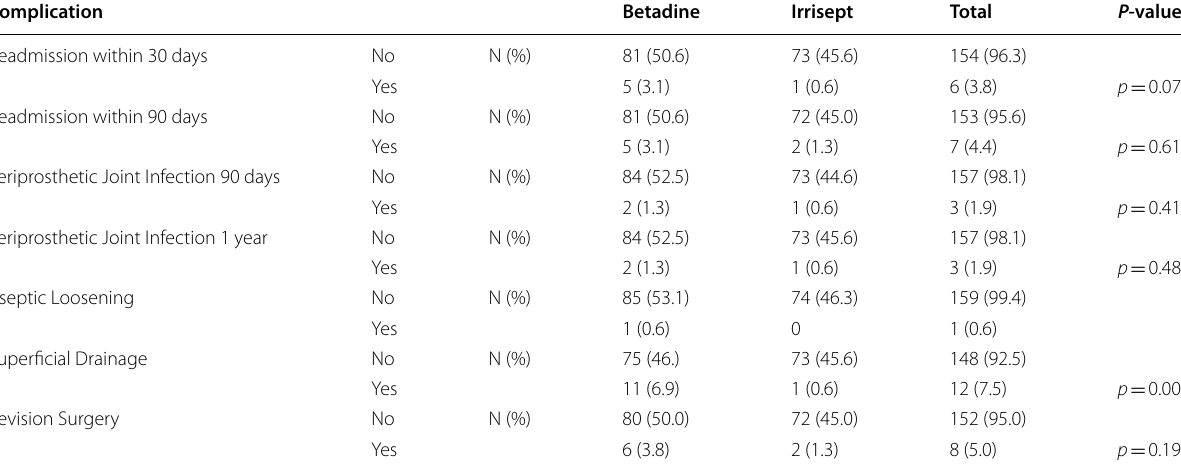
Table 3 Complication rates for betadine versus CHG lavage: total hip arthroplasty